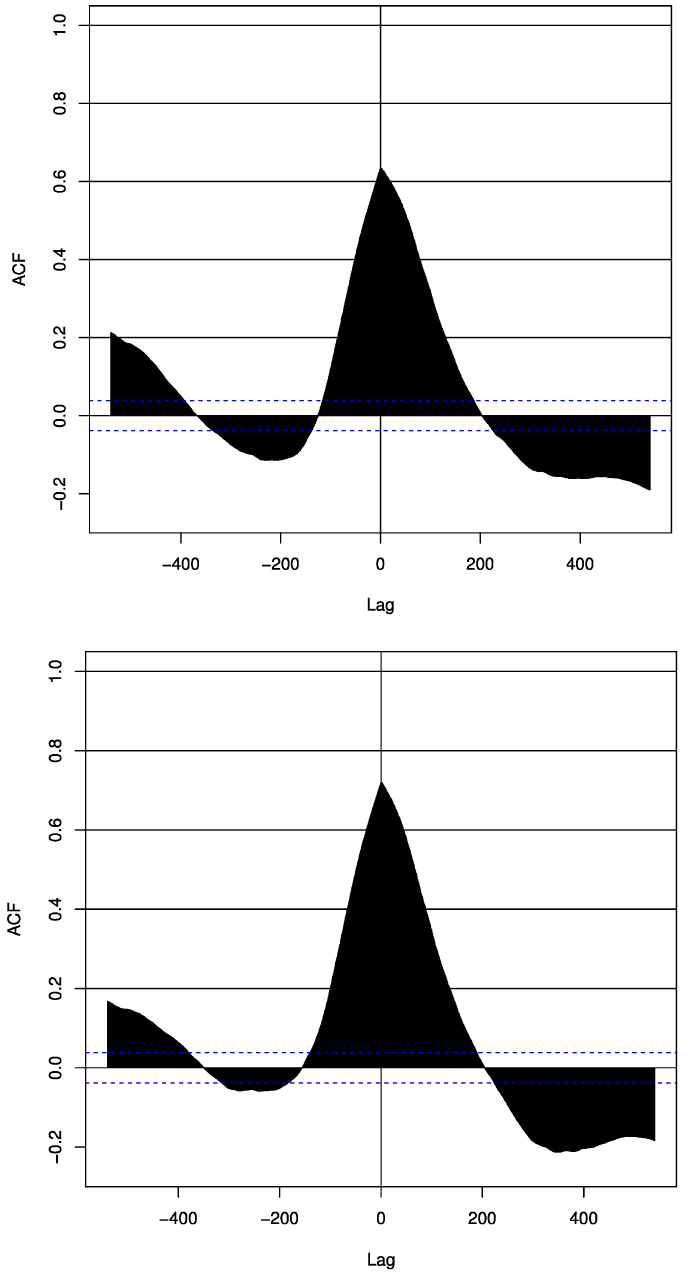
Figure 4. Cross-correlation between long-term futures prices estimated by a stochastic model and spot prices ( top ), and futures prices obtained as the longest maturity on that day and spot prices ( bottom ).